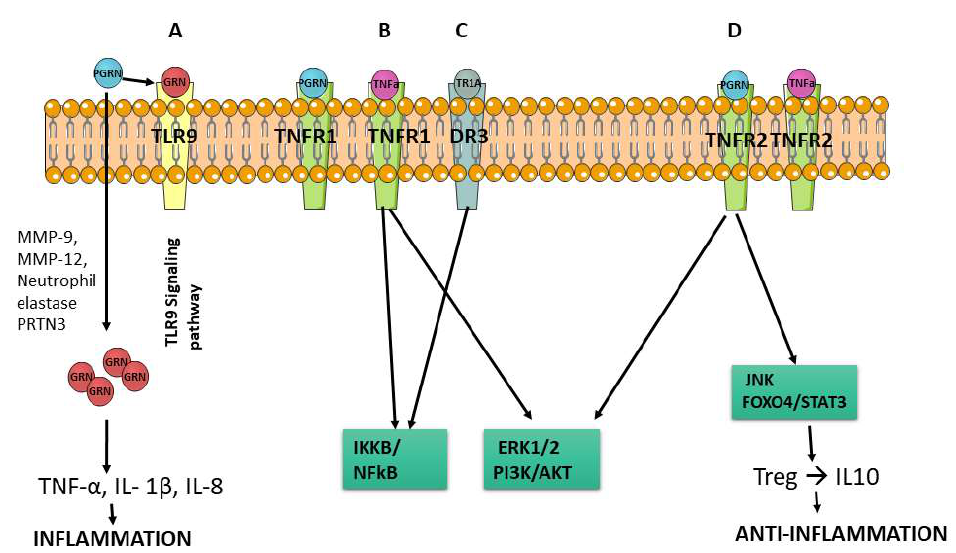
Figure 2. Schematic representation for the principal PGRN and granulin mechanisms. ( A ) TLR9 pathway activated by granulin, the degradation product of PRGN, releasing TNF- α , IL-1 β and IL-8 causing inflammation. ( B ) The inflammatory pathways NF- κ B, ERK1/2 and PI3K/AKT are activated through TNF- α binding to TNFR1. ( C ) PGRN binds to DR3, which has the highest homology to TNFR, interfering with the attachment of DR3 and TL1A. ( D ) PGRN induces the synthesis and secretion of IL-10, from Treg through JNK pathway, depending on